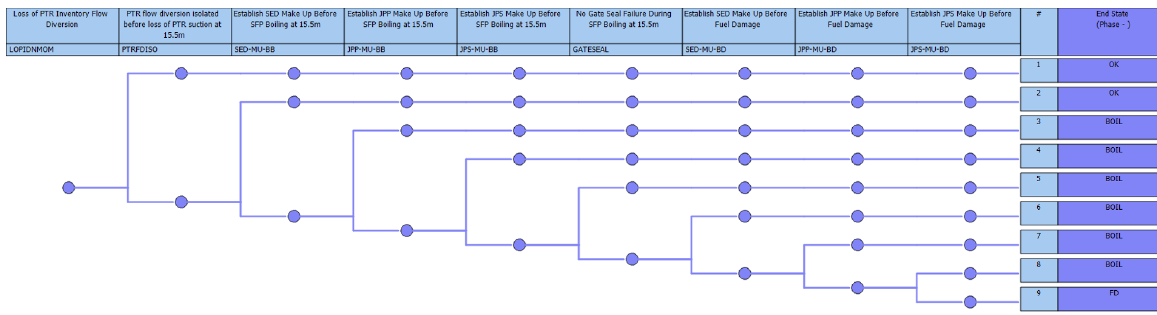
Figure 3. Event tree model of the Loss of Inventory due to Flow Diversion.